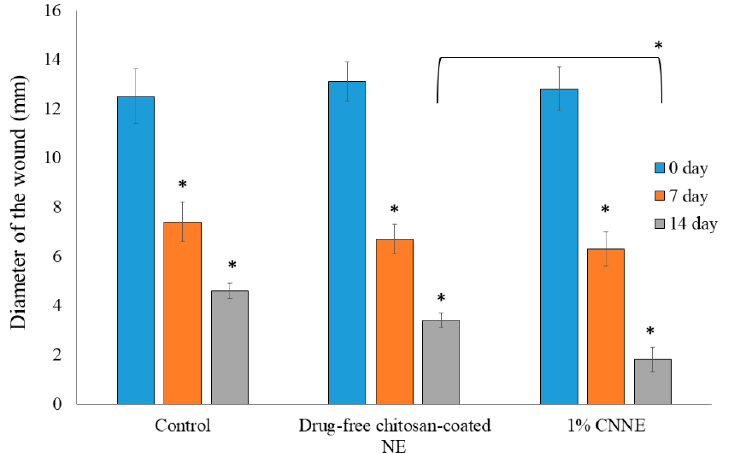
Figure 11. Representation of wound constructions in different experimental groups on the macroscopic measurements. Data are presented as mean ± SEM, where * p < 0.05 compared to the control group ( n = 6).